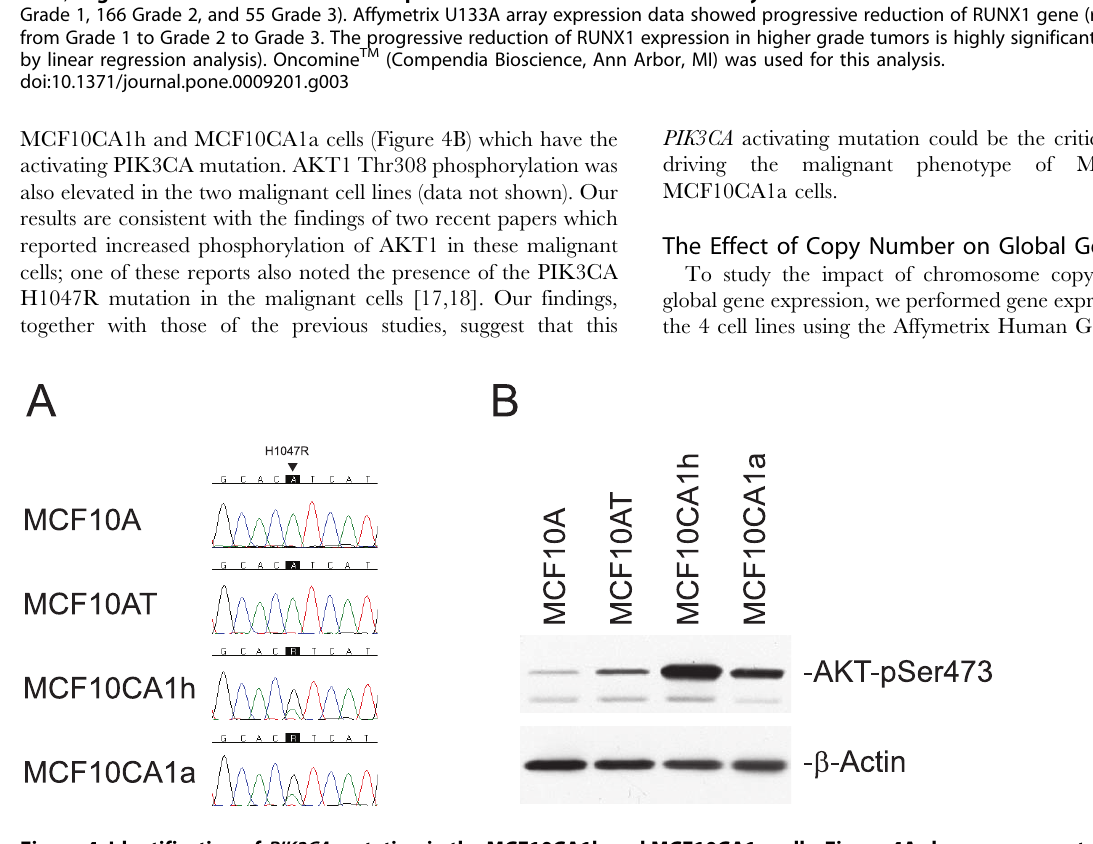
Figure 4. Identification of PIK3CA mutation in the MCF10CA1h and MCF10CA1a cells. Figure 4A shows a segment of the sequencing chromatogram of PIK3CA . MCF10A and MCF10AT cells have a wild type A-allele marked by an arrow. In contrast, MCF10CA1h and MCF10CA1a cells exhibit predominance of the mutant G-allele in addition to the wild type A-allele. The mutation results in an amino acid change from His to Arg at 1047 (H1047R). Figure 4B shows increased phosphorylation of AKT1 Ser473 in the MCF10CA1h and MCF10CA1a cells. An antibody targeting phosphorylated Ser473 in AKT1 recognized specifically the phosphorylated form of the protein, which was dramatically increased in cells containing the PIK3CA activating mutation, i.e. the MCF10CA1h and MCF10CA1a cells. b -actin served as a control for protein